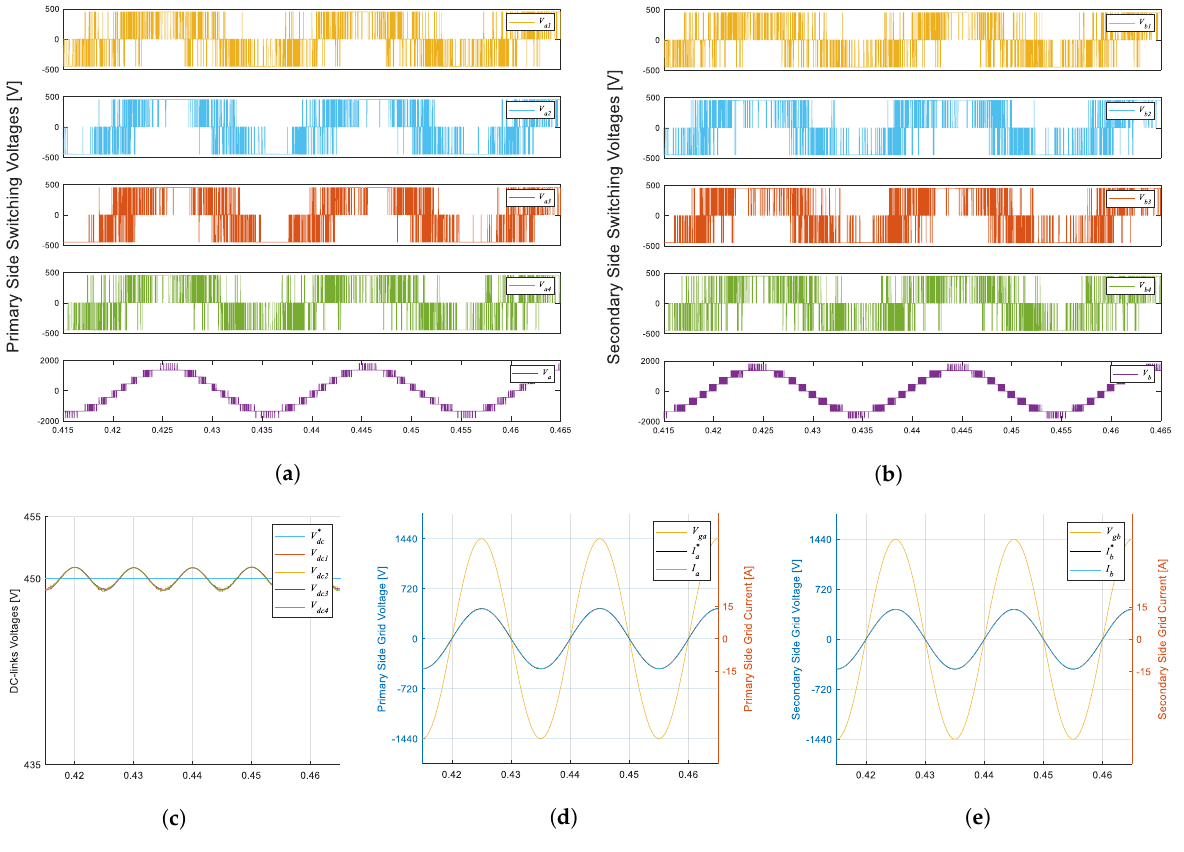
Figure 15. The 4-modules ISOS configuration simulation results: ( a ) primary side switching voltages, ( b ) secondary side switching voltages, ( c ) DC-links voltages, ( d ) primary side grid voltage and current, ( e ) secondary side grid voltage and